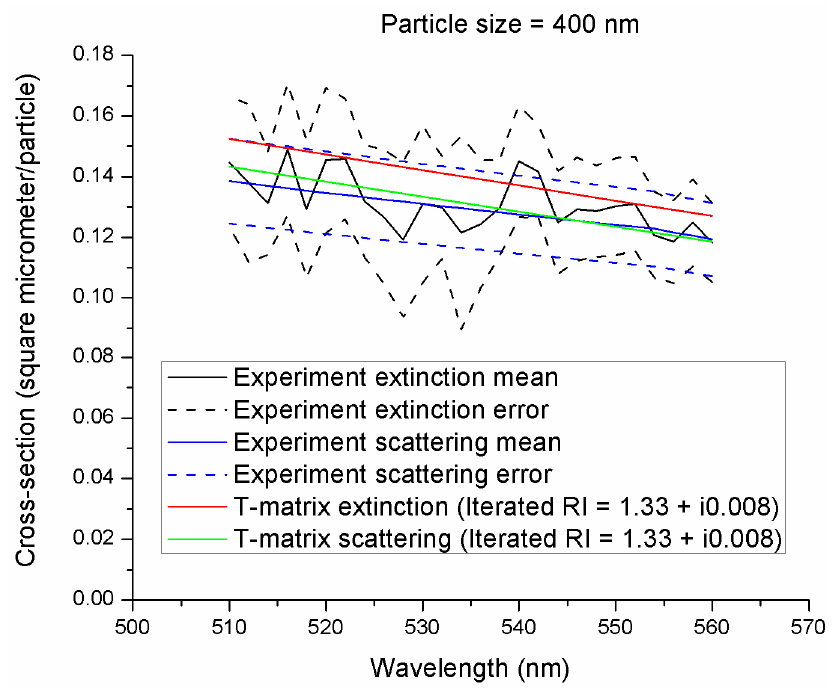
Figure 10. Experimental and calculated values of the extinction and scattering cross-sections for 400-nm particles.